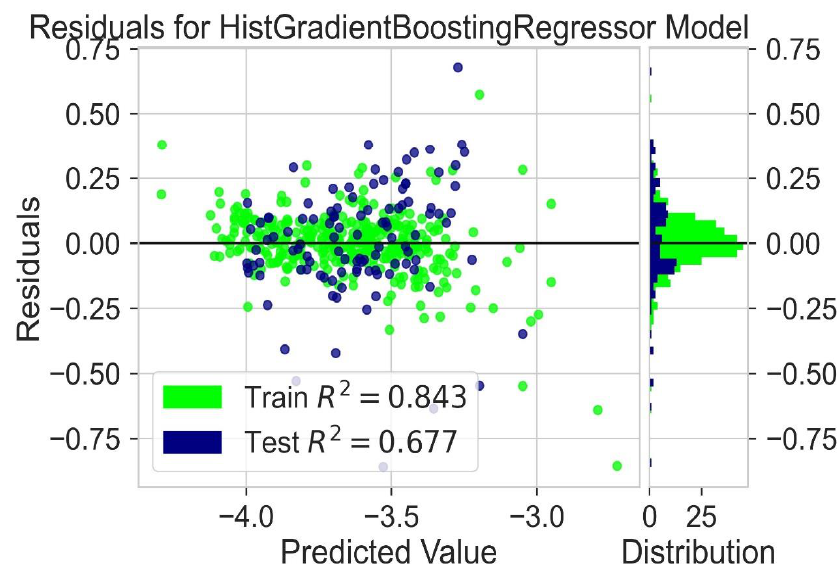
Figure 14. Residuals for Hist gradient booting regression model for LUMO prediction. A scattered plot between the experimental value and expected value of LUMO using the HGBM regression model and Hist gradient regression model is shown in Figure 15 and Figure 16, respectively. The scatter plot is drawn between the residuals for the models and the experimentally predicted value. It is mostly used to find problems with regression models. For data points above the line, residuals are positive. For the data points below the line, the residuals are negative. The closer the value of the data points to 0, the more accurate it is for results. The scatter plot of LGBM and Hist gradient regression models shows that most of the values lie in the low range, near the value of zero, indicating accu- rate results. Figure 15. Scatter plot between experimental and predicted HOMO using LGBM regression model.